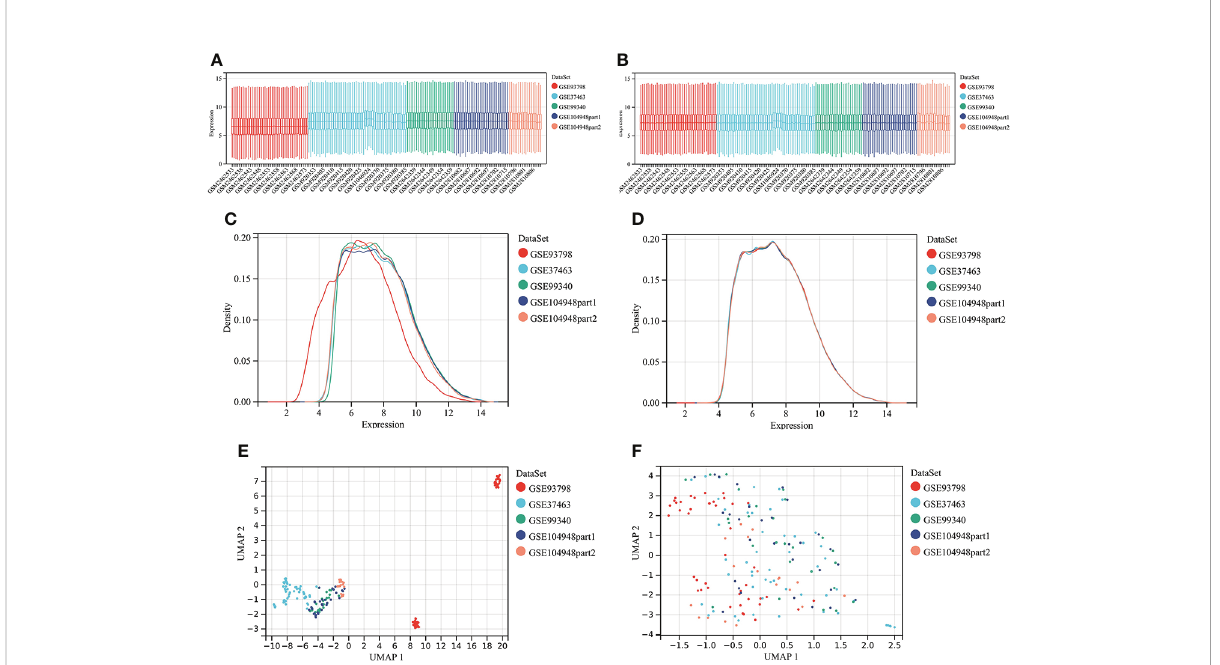
FIGURE 1 Merging datasets and removing batch effect. (A) The box plot of sample distribution of each datasets before the removal of batch effect, which indicated the differences of sample distribution and the existence of batch effect. (B) The box plot of sample distribution of each datasets after the removal of batch effect, which indicated that data distribution tends to be consistent across datasets, with the median in a line. (C) The density plot of sample distribution of each datasets before the removal of batch effect, which indicated the differences of sample distribution and the existence of batch effect. (D) The density plot of sample distribution of each datasets after the removal of batch effect, which indicated that data distribution tends to be consistent across datasets, with the close mean and variance. (E) The UAMP of sample distribution of each datasets before the removal of batch effect; samples from individual datasets are clustered separately, which indicated the existence of batch effect. (F) The UAMP of sample distribution of each datasets after the removal of batch effect; the samples of each datasets were clustered together, suggesting a good removal of batch